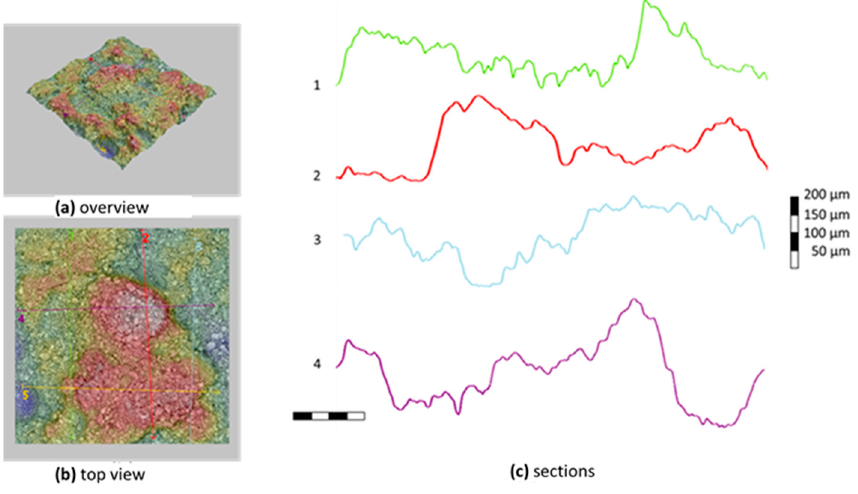
Figure 19. Microtopography of carbon fabric after failure in M120 composites.